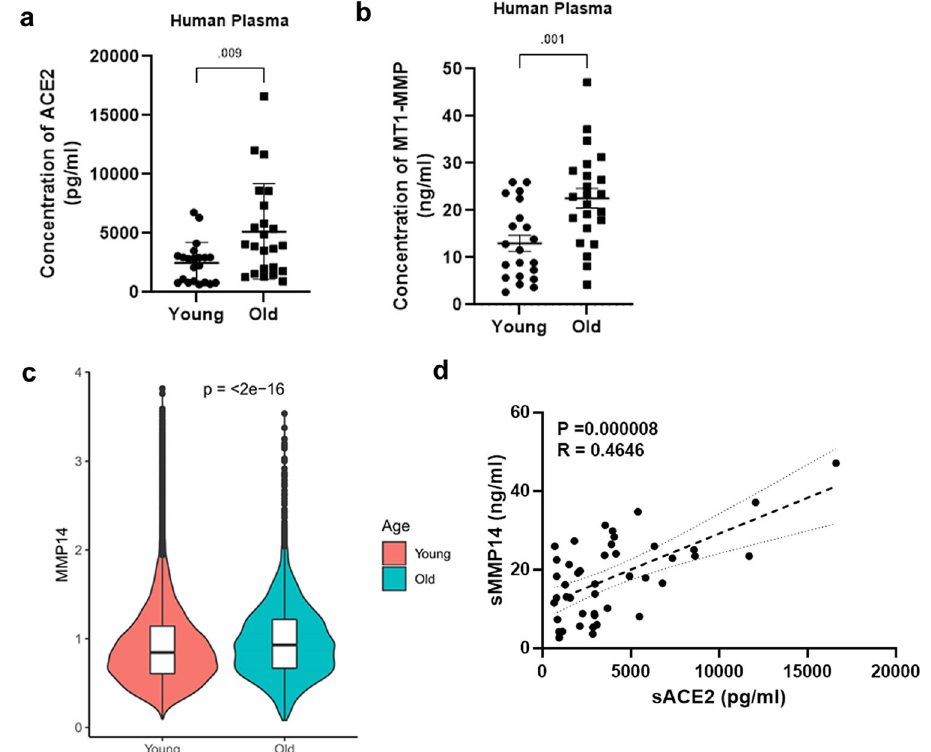
Fig.6|ThepositivecorrelationbetweenMT1-MMPandACE2intheelderly.a,b Expression levels of soluble ACE2 and MT1-MMP in the plasma of young human subjects andaged human subjects weremeasured by ELISA( n =21young people & 23oldpeople)(unpairedtwo-tailed t -test).Thedataareshownasthemeans±SEM. c Comparison of MMP14 expression levels in young human subjects and elderly humansubjects byanalysisof single-celltranscriptomeobtainedfromhumanlung and airway cells (unpaired two-tailed t -test). Boxplots show the median (central